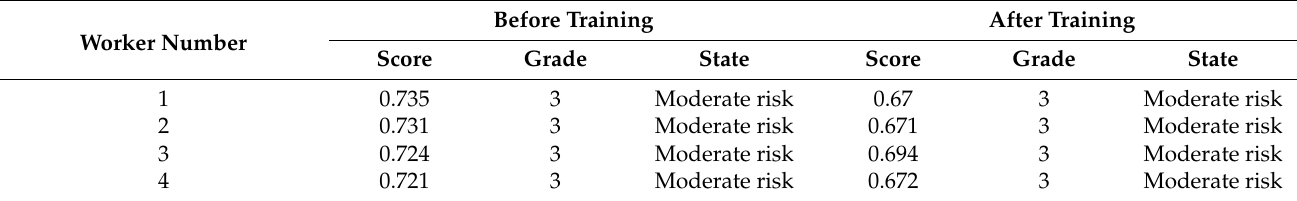
Table 17. Comparison of safety states before and after